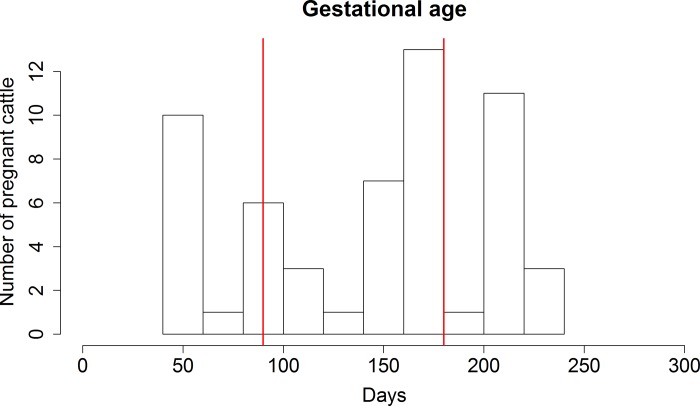
Gestational age of pregnant cattle.Pregnant cattle were distributed in all three trimesters of gestation, indicated by the vertical red lines.